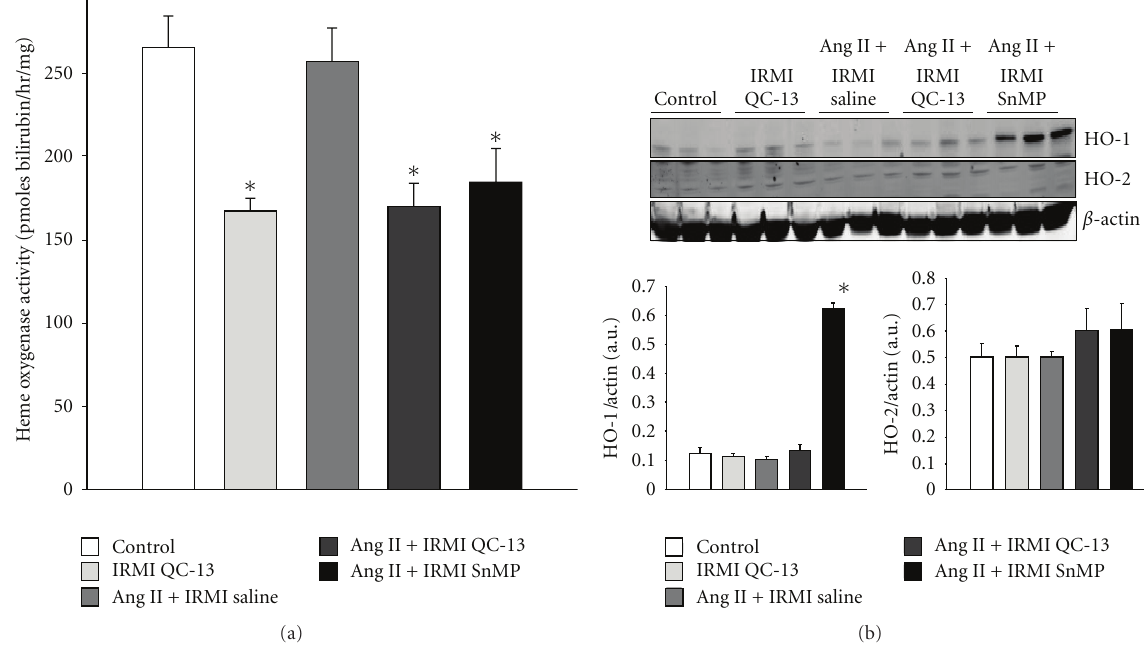
Figure 2: (a) Renal medullary heme oxygenase activity in control, IRMI QC-13, Ang II + IRMI saline, Ang II + IRMI QC-13, and Ang II + IRMI SnMP-treated mice, n = 6/group. (b) Representative western blots of HO-1 and HO-2 proteins from the renal medulla of control, IRMI QC-13, Ang II + vehicle, Ang II + IRMI QC-13, and Ang II + IRMI SnMP-treated mice, n = 3/group. ∗ P < 0 . 05 as compared to value in control mice.